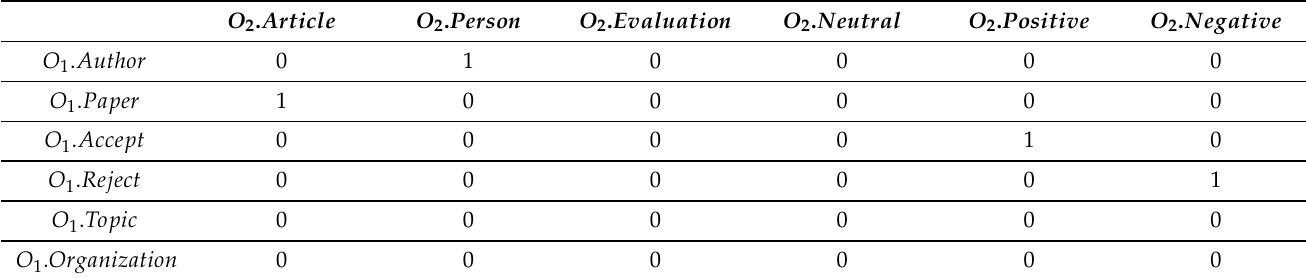
Table 1. An example of mapping